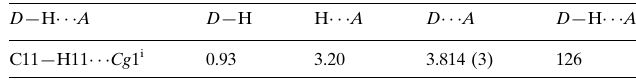
Hydrogen-bond geometry (A˚ , (cid:1)